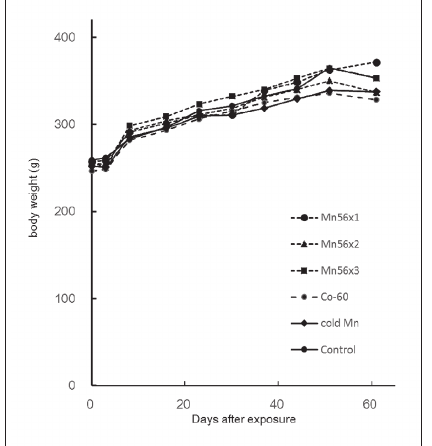
Figure 1. Changes in body weight after exposure. Ten-week-old male Wistar rats were exposed to 3 different activities of 56 MnO 2 powder: Mn56×1 (circle/dotted line), Mn56×2 (triangle/dotted line), and Mn56×3 (square/ dotted line); 1 Gy of whole-body 60 Co γ -ray irradiation: Co-60 (circle/broken line); cold MnO powder: cold Mn (rhombus/straight line); 2 or control (circle/straight Table 2. Body and relative organ weights in rats exposed to 56 MnO , Co-60 γ rays, and cold MnO 2 Body